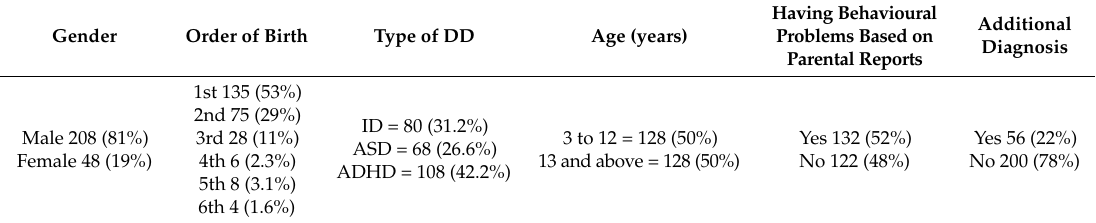
Table 2. Children demographic